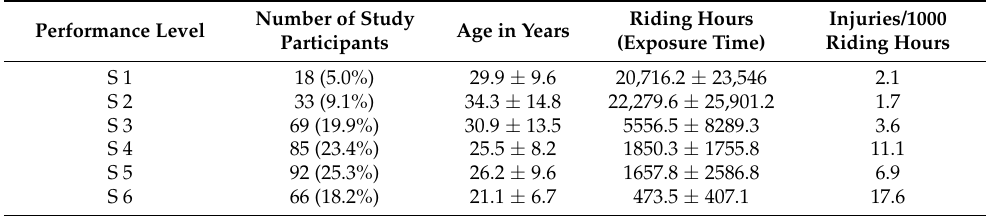
Table 1. The distribution of the study participants according to performance